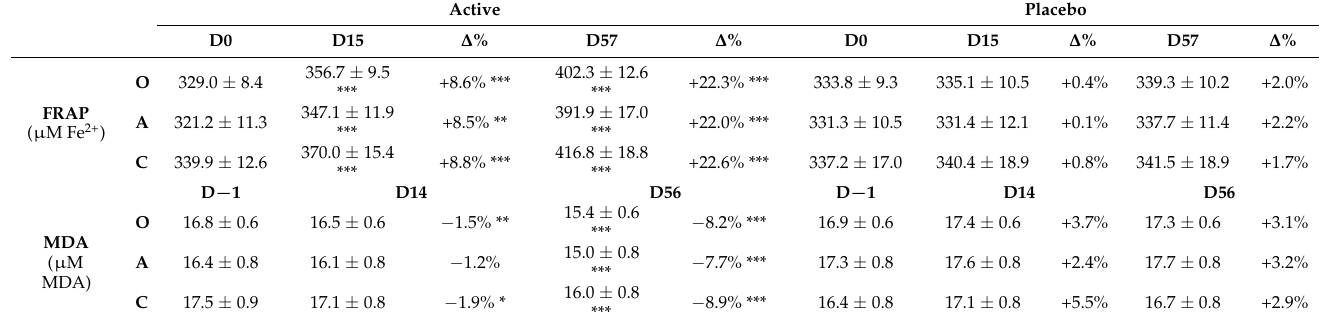
Table 1. FRAP and basal MDA results. The intragroup (vs. baseline) statistical analysis is reported near the raw data, while the intergroup (active vs. placebo) statistical analysis is reported near the % variation ( ∆ %). The statistical analysis is reported as follows: * p < 0.05, ** p < 0.01, and *** p <